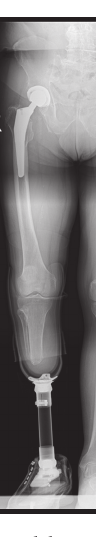
Figure 4: Uncemented total hip arthroplasty with the lower leg